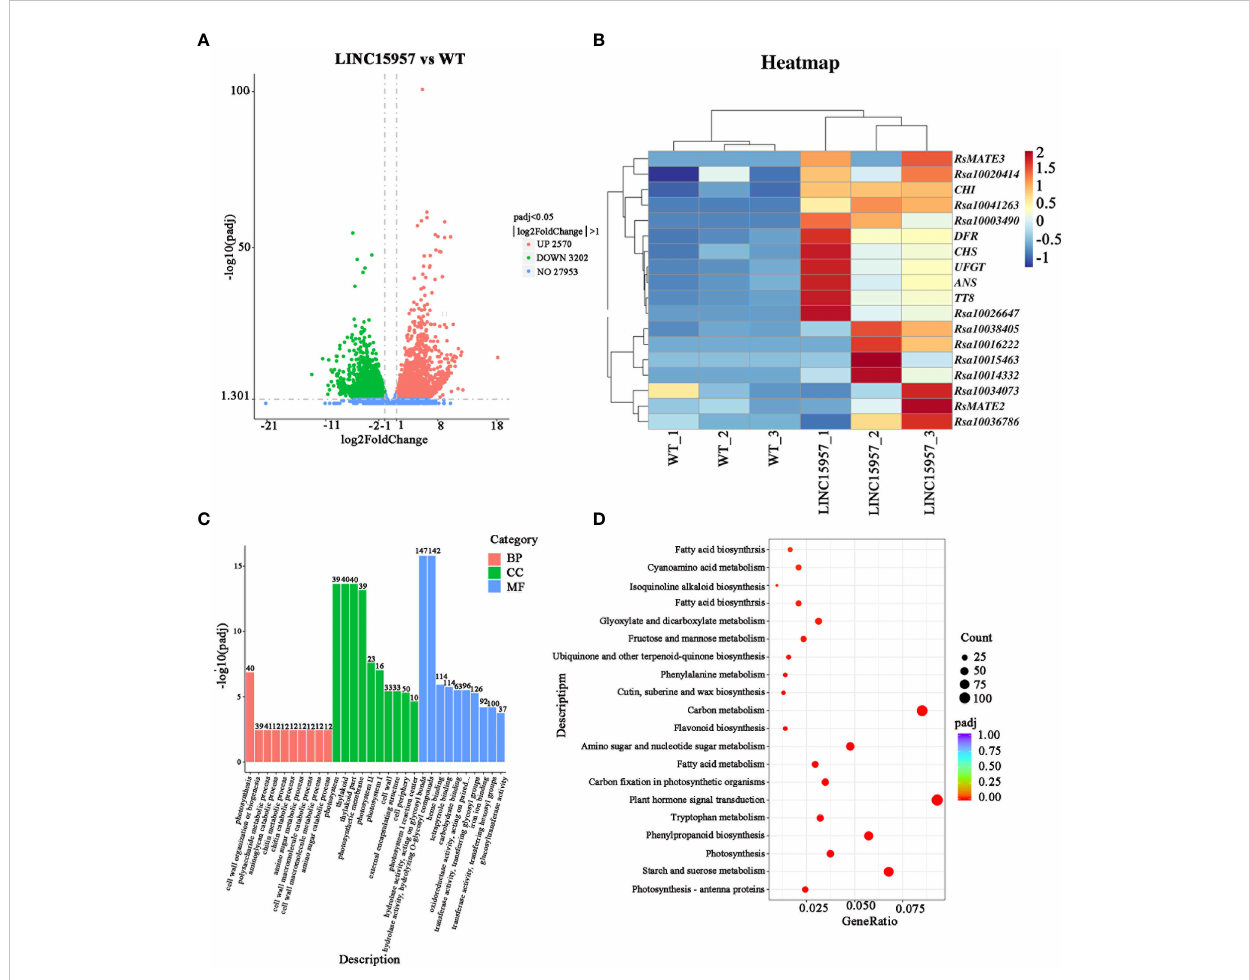
FIGURE 4 Transcriptome analysis in WT vs. OE- LINC15957 . (A) Volcano plot showing the differentially expressed genes (DEGs) in red and green. The X-axis represents the fold change in WT vs. OE- LINC15957 (on a log 2 scale). The Y-axis represents the negative log 10 transformed average FPKM values. (B) Expression levels of the 6 core genes and 12 transcription factors involved in anthocyanin biosynthesis in radish leaves. Each square represents the transcription level in the two processes (WT and overexpressing LINC15957 ) at radish leaves. Different color indicates differences in the level of gene expression, from high (red) to low (blue). (C) Gene Ontology (GO) enrichment analysist for differentially expressed genes (DEGs) between WT and OE- LINC15957 . (D) Kyoto Encyclopedia of Genes and Genomes (KEGG) enrichment analysis of the